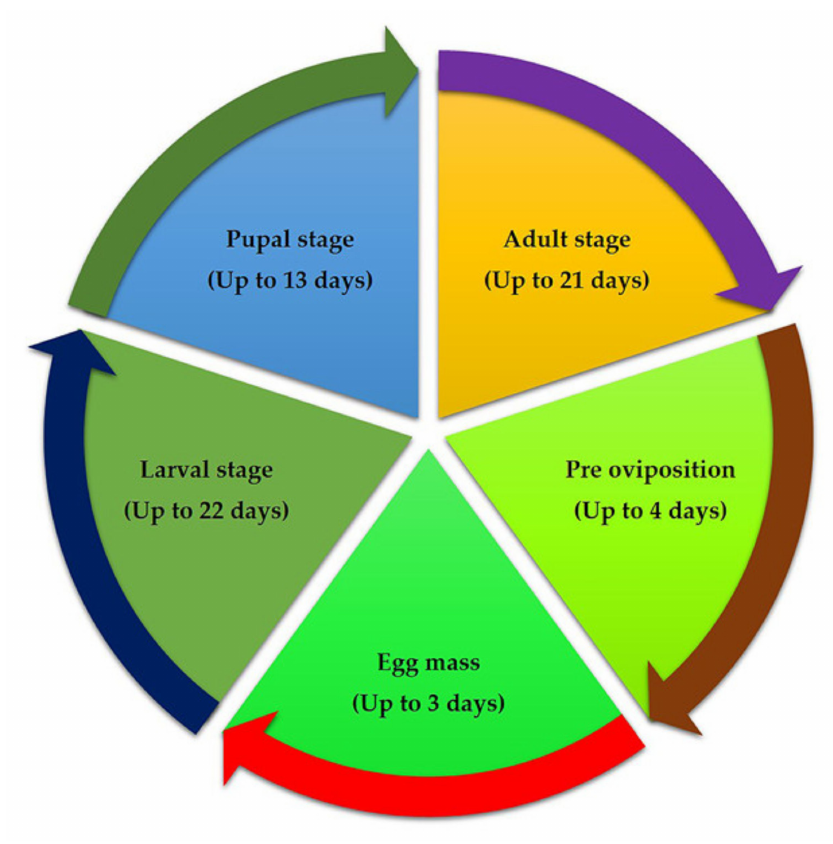
Figure 2. Life cycle of fall armyworm of